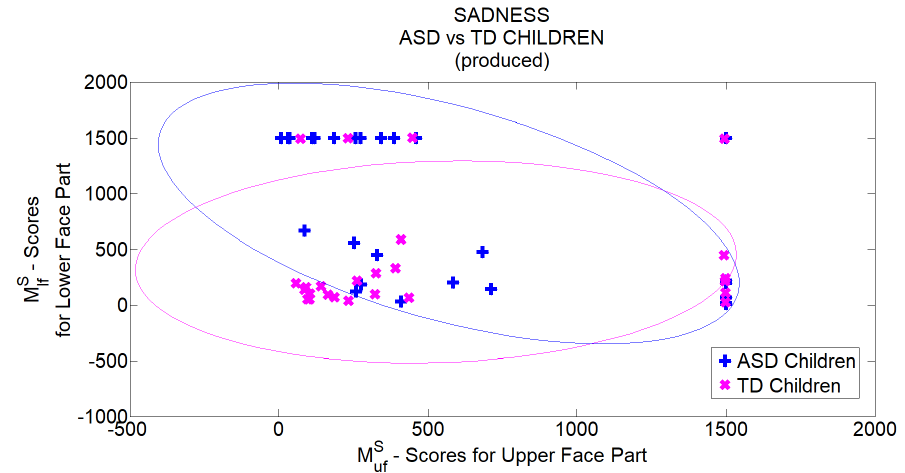
Figure 14. Comparison of the scores computed for the production of Sad expressions by ASD and TD children.